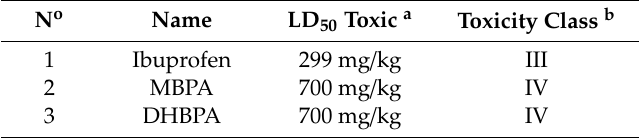
Table 5. Toxicity prediction of the ibuprofen and benzoylpropionic acid derivatives. N